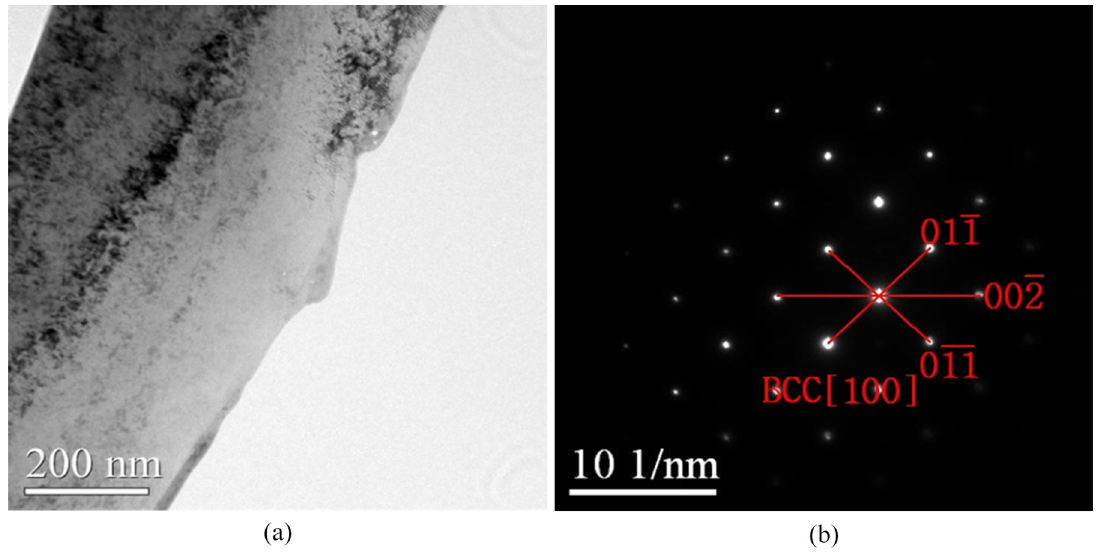
Figure 7. TEM micrographs of 5µm Fe-11.7Mn alloy powders (a) matrix, (b) SAED